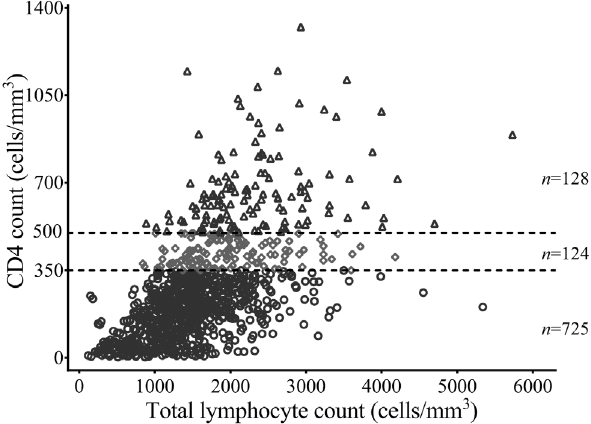
Figure 1. Scatter plot for 977 pairs of total lymphocyte count (TLC) and CD4 cell count. The lower circle dots are for 725 pairs of TLC (median [interquartile], 1370 [1025–1760] cells/mm 3 ) and CD4 cell count of less than 350 cells/mm 3 . The middle diamond dots are for 124 pairs of TLC (median [interquartile], 1885 [1500–2355] cells/mm 3 ) and CD4 cell count of between 350 cells/mm 3 and 500 cells/mm 3 . The upper triangle dots are for 128 pairs of TLC (median [interquartile], 2222 [1840–2698] cells/mm 3 ) and CD4 cell count of greater than 500 cells/ mm 3 .